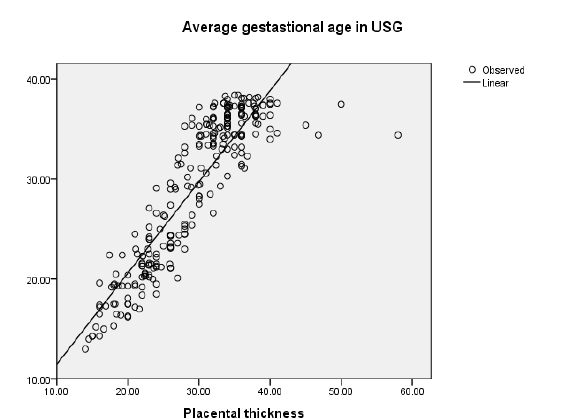
Fig. 1: Scatter plot diagram showing distribution between PT and GA